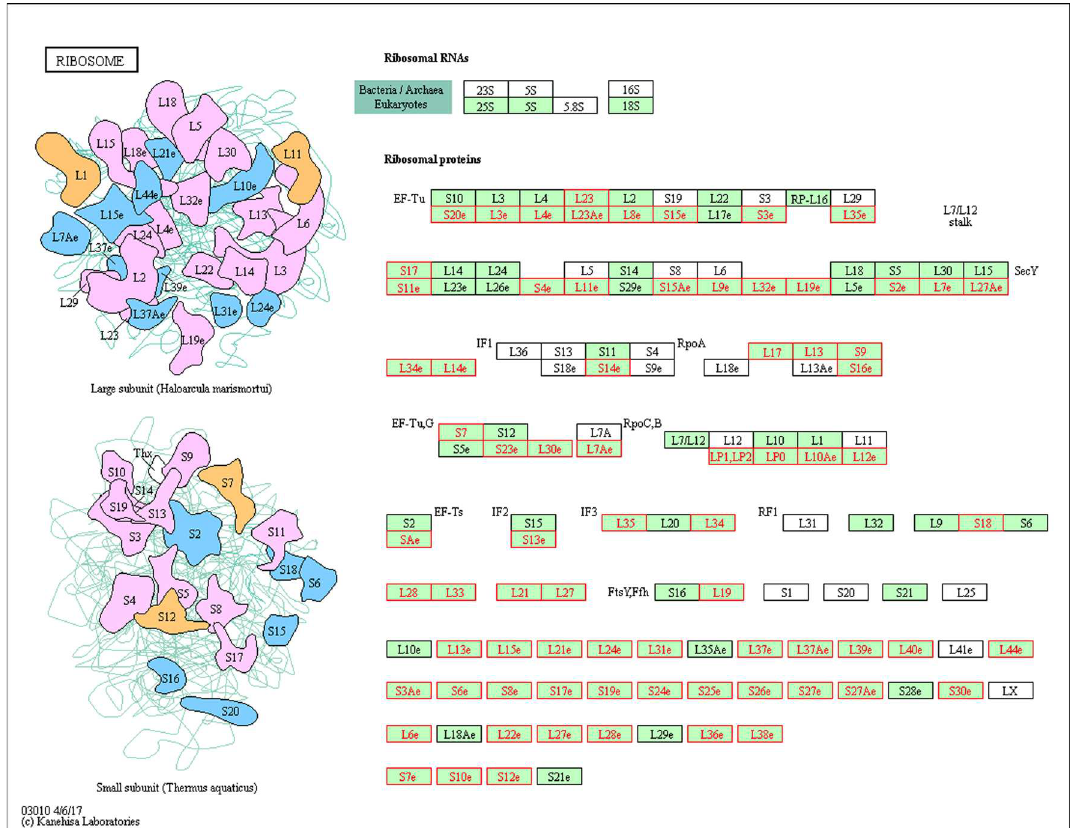
Fig 8. Differentially spliced ribosomal genes (colored